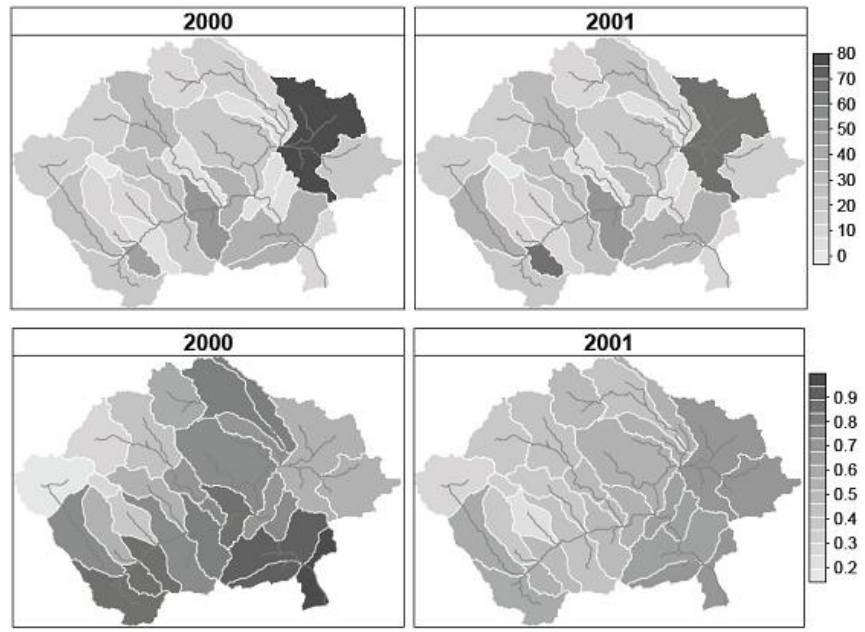
Fig. 8. Total nitrogen emissions (top panel, in tyr − 1 ) and nitrogen retention (bottom panel, as a fraction of total nitrogen emissions) per subcatchment on a dry year (2000, 670mm annual rainfall) and a wet year (2001, 727mm annual